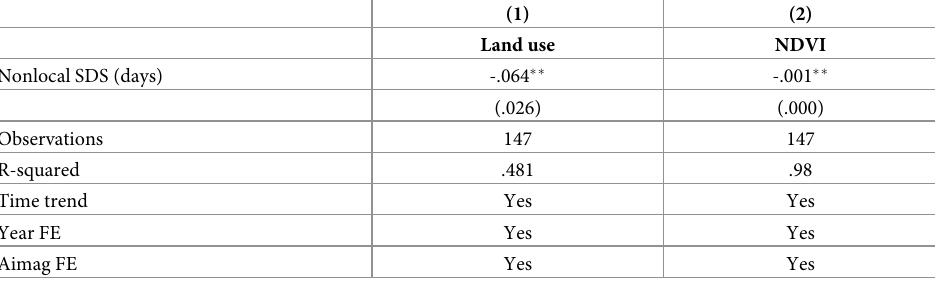
Table 6. Impact of sand and dust storms on land use and vegetation cover (ground